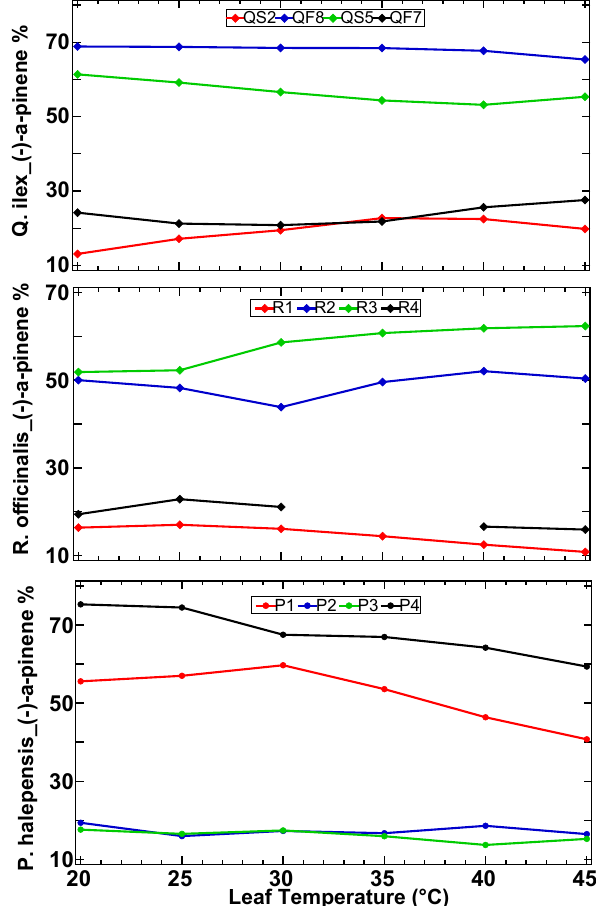
Fig. 7. Enantiomeric fraction of ( − )- α -pinene in the emission of Quercus ilex , Rosmarinus officinalis and Pinus halepensis as a func- tion of